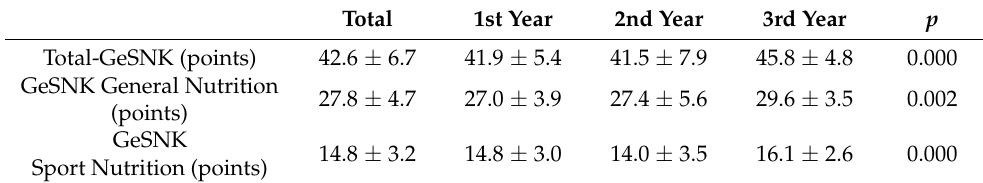
Table 2. GeSNK knowledge level score of the participants in the three secondary school